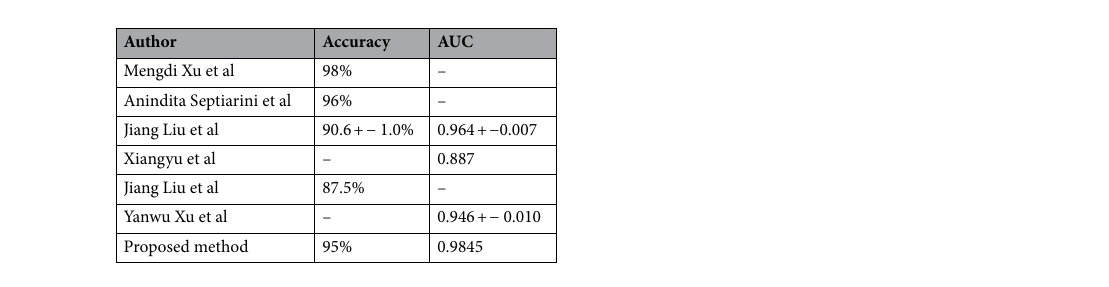
Table 2. Comparison